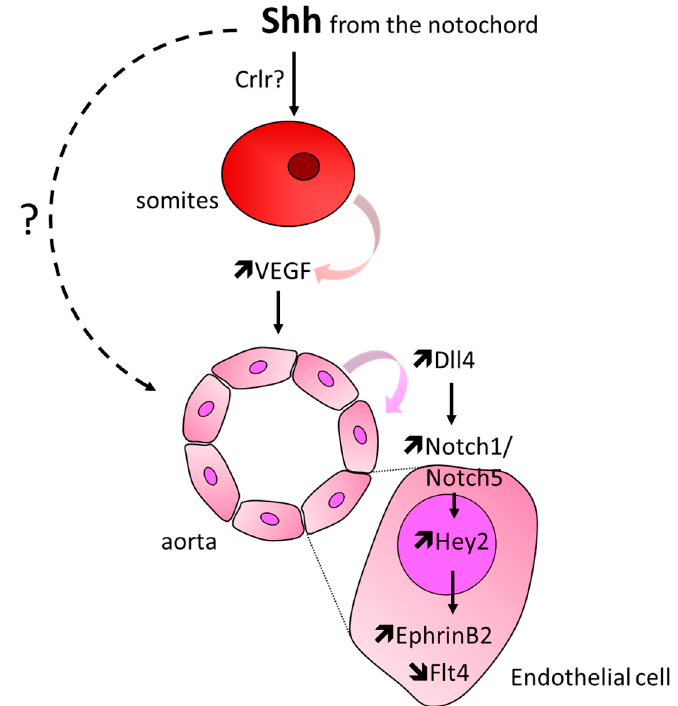
Figure 4. Schema representing the main cellular events involved in Hh-induced arterial di ff erentiation. Briefly, Shh produced by the notochord upregulates Vegfa in somites, which, in turn, increases Notch signaling in ECs, and subsequently promotes the expression of the arterial marker EphrinB2.